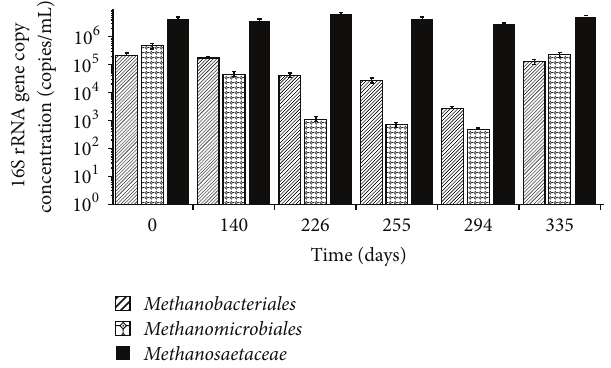
Figure 2: Absolute quantification of the 16S rRNA gene concentra- tionofthemethanogenic/archaealpopulationsduringpsychrophilic (10 ∘ C) EGSB bioreactor